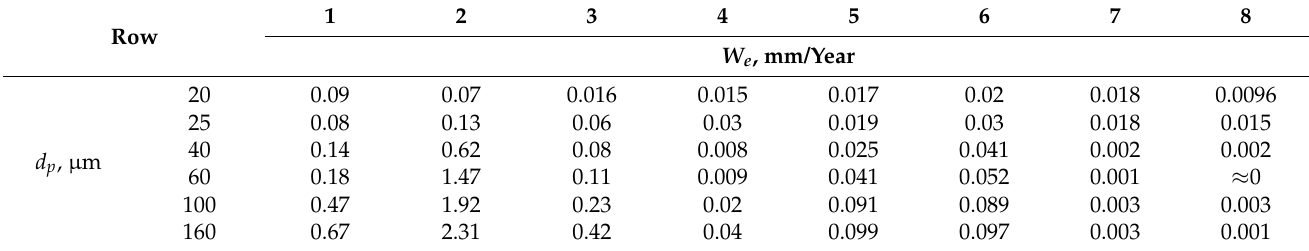
Table 2. The maximum annual erosive wear rate of the rows of elements in the separator with arc-shaped elements